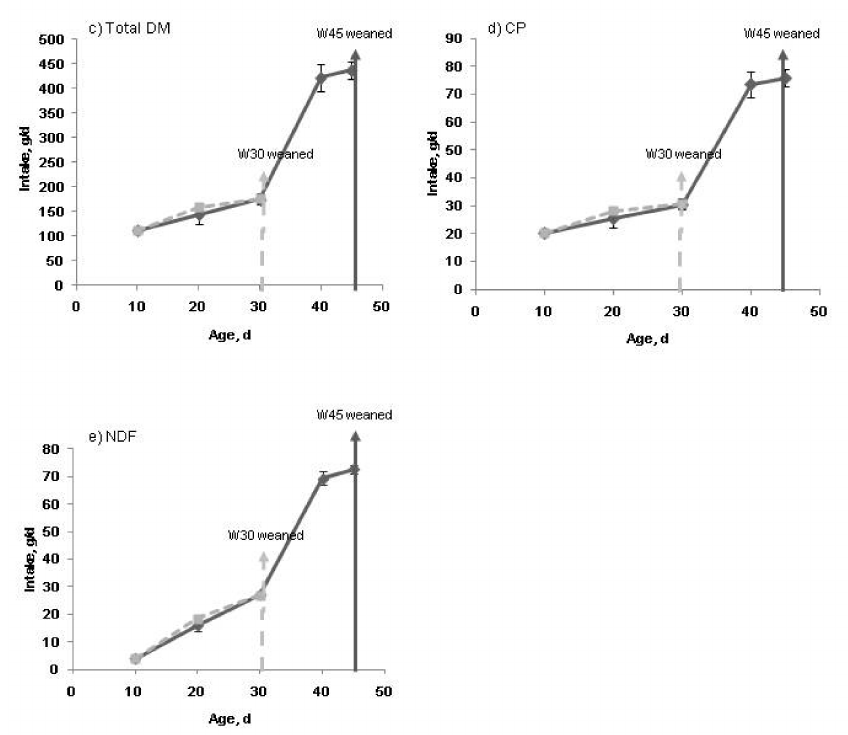
Figure 1. Intake of starter pellets ( a ); hay of Chinese wild rye hay ( b ); total dry matter (DM, ( c )); crude protein (CP, ( d )); and neutral detergent fiber (NDF, ( e )) at di ff erent ages of the growing lambs before weaning. Dashed line, lambs weaned at d 30 (W30); Solid line, lambs weaned at d 45 (W45). Error bars indicate SE. # 0.05 < p < 0.10.